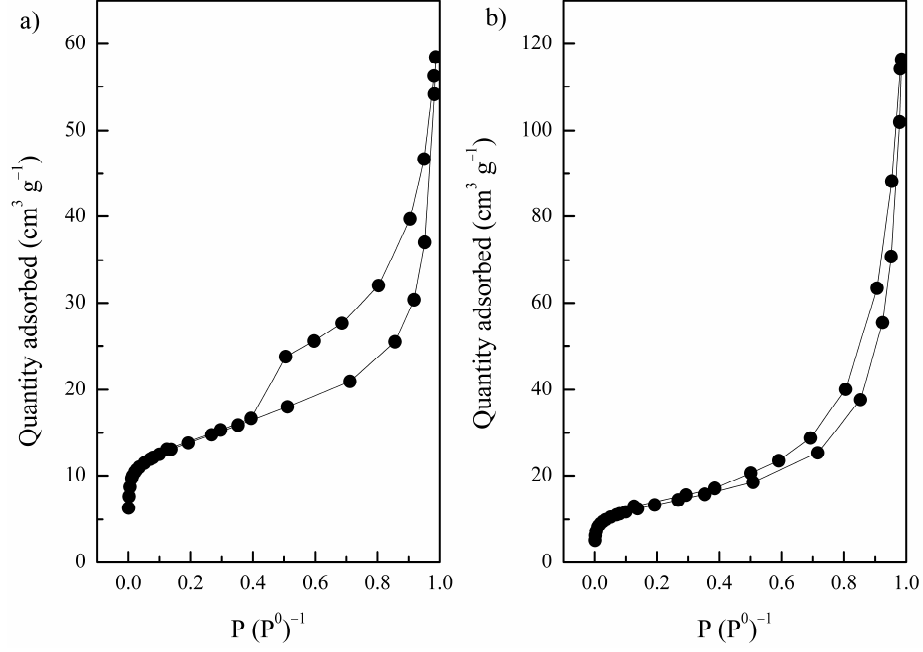
Figure 3. N 2 adsorption–desorption isotherms for: ( a ) natural bentonite; ( b ) silica-resin-bentonite